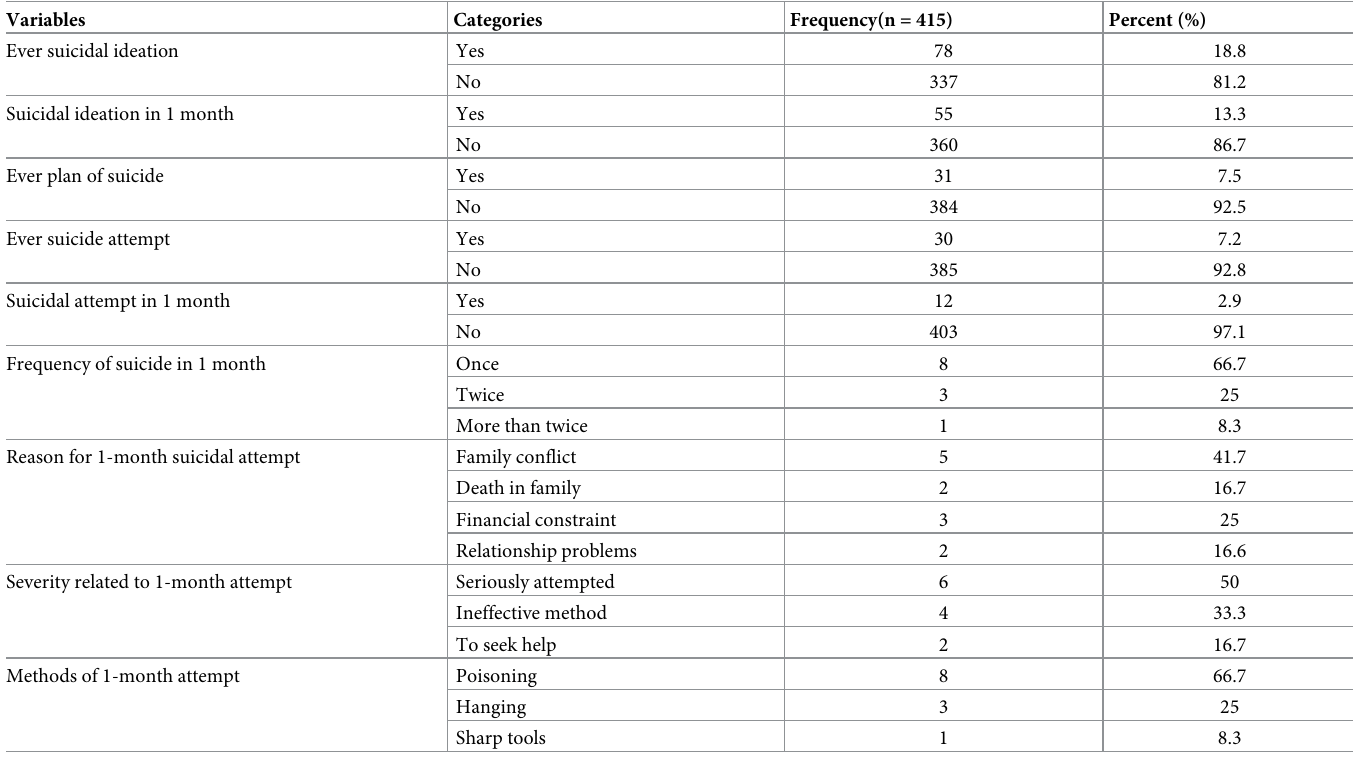
Table 5. Distribution of suicidal ideation and attempt among pregnant women attending antenatal care at Jimma medical center, Jimma, Southwest, Ethiopia, 2020 (N = 415).